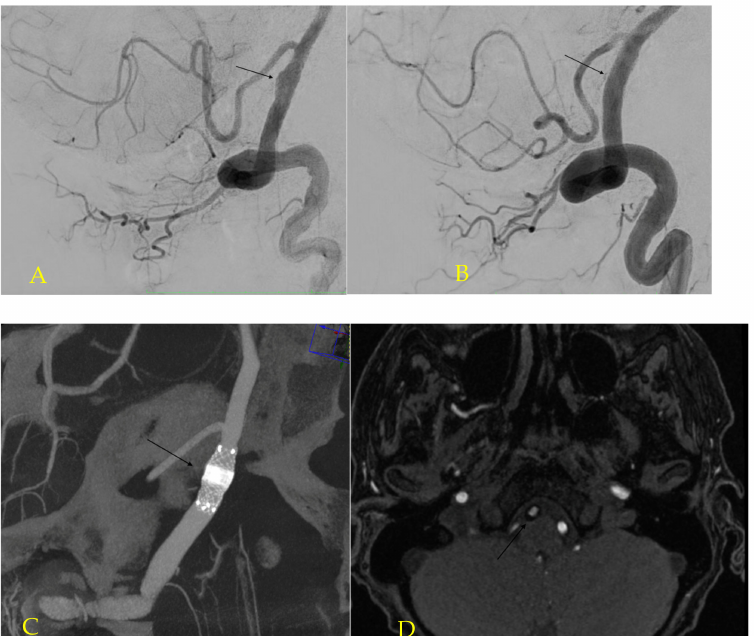
Figure 1. Pretreatment right vertebral lateral angiography ( A ) shows the blood blister-like aneurysm (arrow) below posterior inferior cerebellar artery (PICA). Postembolization angiography ( B ) reveals reduced filling of the aneurysm’s sac. Excellent apposition to the vessel wall and compacting the mesh around the aneurysm’s neck are visualized on intraprocedural contrast-enhanced flat panel detector CT (MIP reconstruction) ( C ). One year following the treatment, MRI revealed good positioning of the stent (arrow) and complete occlusion of the aneurysm ( D